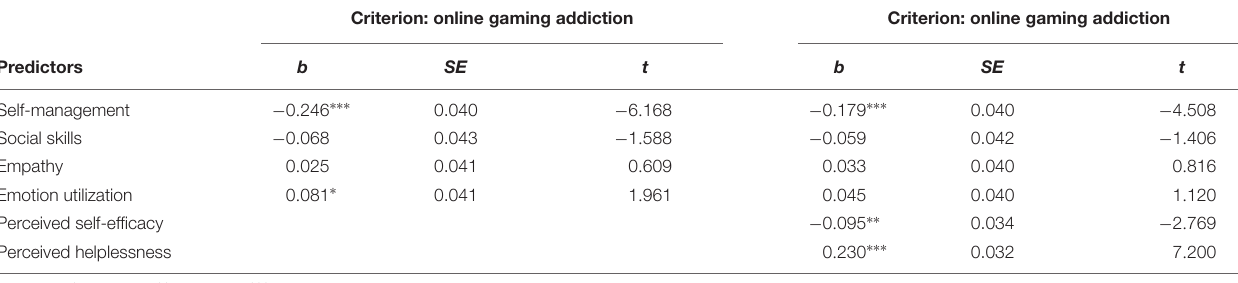
TABLE 2 | Effects of four dimensions of emotional intelligence and two facets of perceived stress on online gaming addiction. Criterion: online gaming addiction